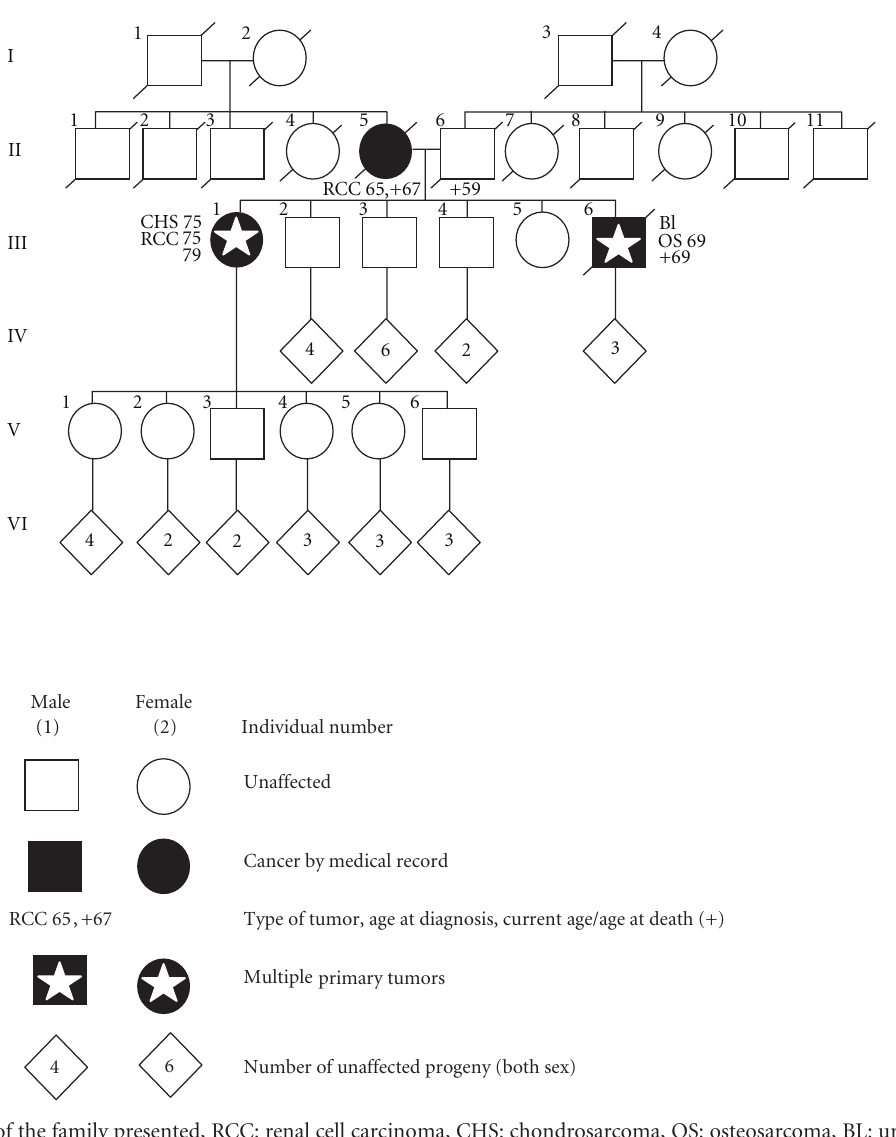
Figure 3: Pedigree of the family presented, RCC: renal cell carcinoma, CHS: chondrosarcoma, OS: osteosarcoma, BL: urothelial carcinoma of the bladder.